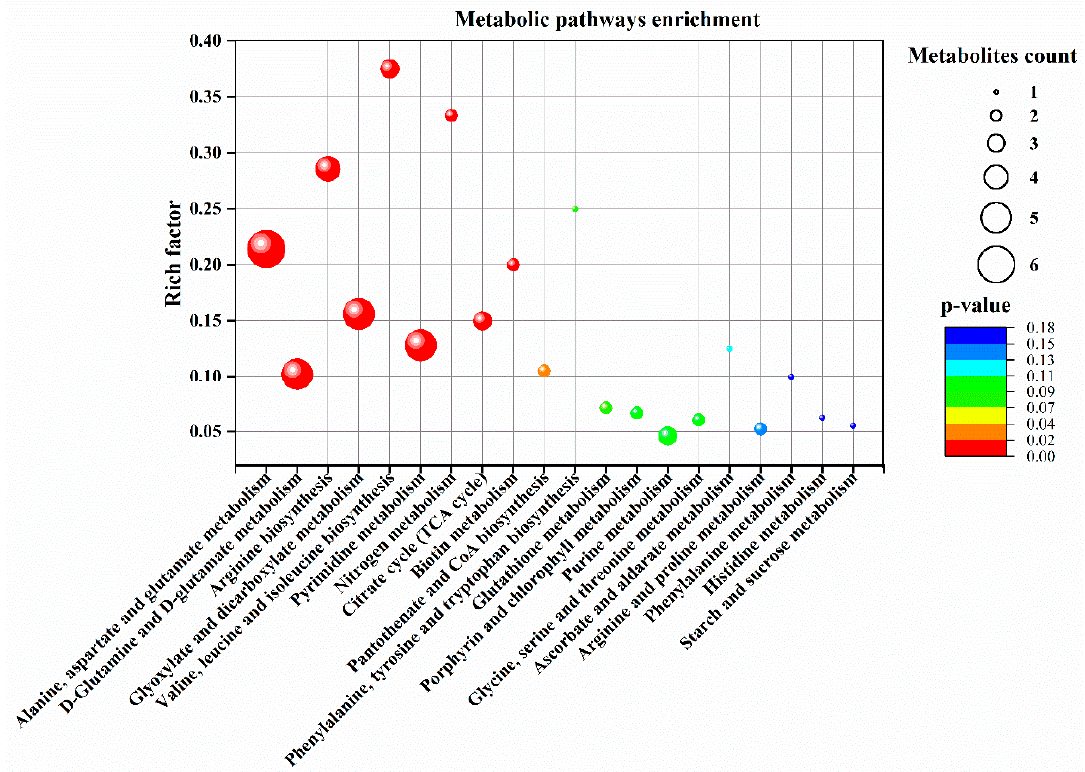
Figure 8. Metabolic pathways enrichment analysis of 20 significantly up-regulated metabolites by aspartate (Asp, 2 mM) in perennial ryegrass leaves at 30 d of heat stress. The bubble size represents the number of Asp-responsive metabolites enriched in a given metabolic pathway. The color of bubbles represents the level of significance based on the LSD test ( p = 0.05).